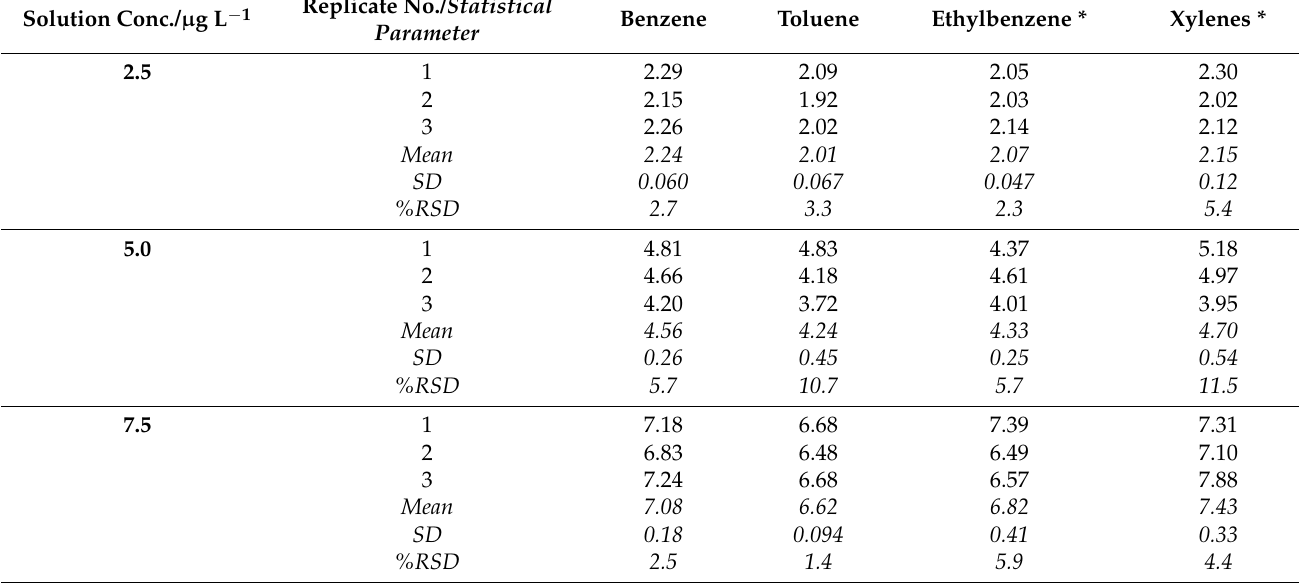
Table 9. Accuracy data ( µ g L − 1 in solution) for each of the triplicate measurements of 2.5, 5.0, and 7.5 µ g L − 1 BTEX spikes in drinking water (Cambridge, UK). The mean, standard deviation (SD), and RSD (in %) are also shown.